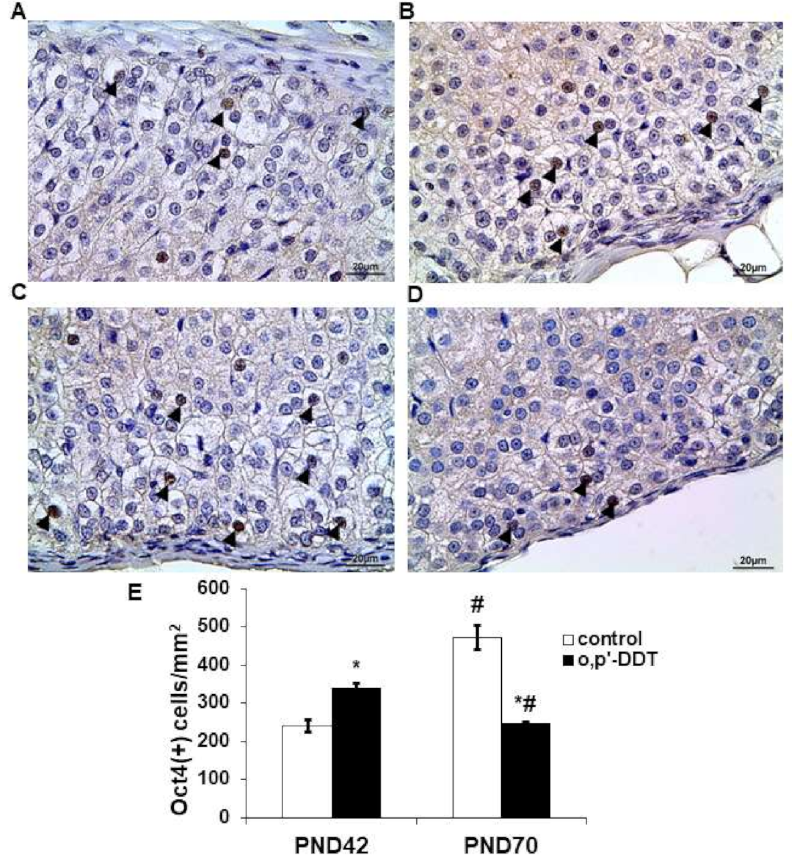
Figure 4. Changes in expression of Oct4 in glomerulosa cells after developmental exposure to low doses of o,p’-DDT. Immunohistochemical detection in the zona glomerulosa of the control ( A ) and DDT-exposed ( B ) rats in pubertal period (PND42) and of the control ( C ) and DDT-exposed ( D ) rats after puberty (PND70). Arrowheads point to Oct4-positive cells in the zona glomerulosa. Scale bar 20 µ m. ( E ) Number of Oct4-positive cells in 1 mm 2 of the zona glomerulosa; Data are shown as mean ± S.E.M. PND, day of postnatal development; p < 0.05 compared to the control (*), compared to PND42